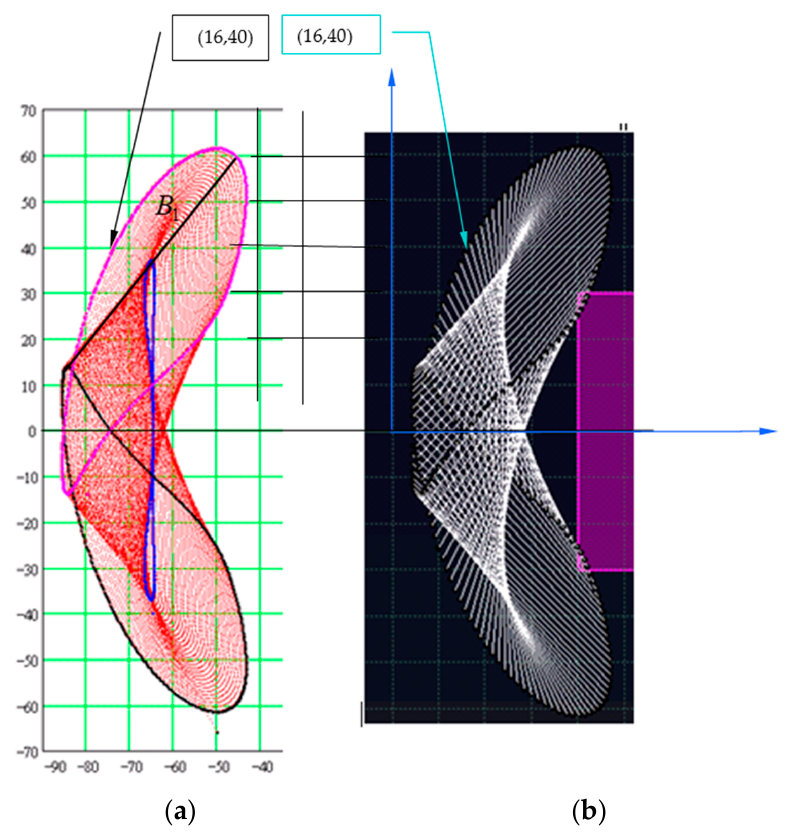
Figure 9. The geometrical loci of a straight line (B 1 ) attached to element 1, with respect to element 2: ( a ) analytical and ( b ) numerical results.